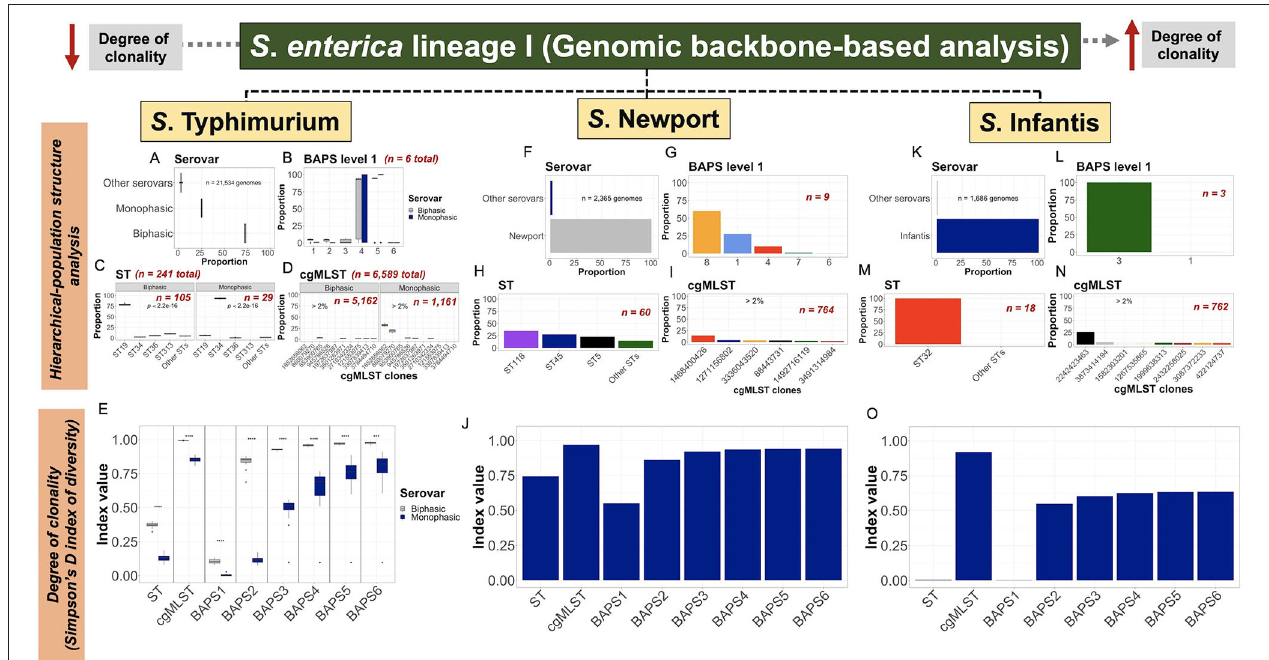
FIGURE 3 | Scalable core-genomic analysis of three zoonotic serovars of S . enterica lineage I linked population structure and genetic diversity with degree of clonality. Core-genomes (i.e., share-genomic content) alignments, generated independently for S . Typhimurium, S . Newport, or S . Infantis dataset, were hierarchically classified into serovar, BAPS1, ST, and cgMLST. Serovar was predicted using the cgMLST-based genotyping done by SISTR within ProkEvo. Frequency distributions were initially produced at each level of classification, and thereafter converted into proportions for population structure analysis; or used as input data (i.e., frequencies) for estimating the degree of clonality using the Simpson’s D index of diversity (1— D ). (A–D) Proportion of serovar ( n = 21,524 genomes), BAPS1 ( n = 21,524 genomes), ST ( n = 21,309 genomes), and cgMLST ( n = 19,226) classifications for S . Typhimurium (initial input of n = 21,534 genomes—“Worldwide”). (E) S . Typhimurium degree of clonality stratified by serotypic classification into: Biphasic vs. Monophasic; across ST ( n = 21,309 genomes), cgMLST ( n = 19,226 genomes), and BAPS1-6 levels ( n = 21,524 genomes for each BAPS layer from 1 to 6). A two-sided t- test was used to determine whether the two serovars significantly differed ( p < 0.05) from one another in their degree of clonality across genotypic levels. (F–I) Proportion of serovar ( n = 2,365 genomes), BAPS1 ( n = 2,365 genomes), ST ( n = 2,361 genomes), and cgMLST ( n = 2,289 genomes) classifications for S . Newport (initial input of n = 2,365 genomes—“USA only”). (J) Degree of clonality across the S . Newport population across ST ( n = 2,361 genomes), cgMLST ( n = 2,289 genomes), and BAPS1-6 levels of genotypic resolution ( n = 2,365 genomes for each BAPS layer from 1 to 6). (K–N) Proportion of serovar ( n = 1,686 genomes), BAPS1 ( n = 1,685 genomes), ST ( n = 1,683 genomes), and cgMLST ( n = 1,659 genomes) classifications for S . Infantis (initial input of n = 1,686 genomes—“USA only”). (O) Degree of clonality across the S . Infantis population using ST ( n = 1,683 genomes), cgMLST ( n = 1,659 genomes), and BAPS1-6 levels of genotypic resolution ( n = 1,685 genomes for each BAPS layer from 1 to 6). For the degree of clonality, the higher the value for the Simpson’s D index of diversity (index value), the less clonal or the more diverse the population is, at that specific level of genotypic resolution. Numbers ( n ) located inside and outside of each plot refers to the total number of sub-groups/haplotypes (BAPS1), ST lineages, and cgMLST variants found within the population, or sub-population (i.e., Biphasic vs. Monophasic), of each serovar. Missing values were dropped for all analyses to keep only genomes correctly classified by SISTR to that specific serovar. Of note, “Other serovars” represents serovars that were either not classified as any of the three ones used in this work, or were misclassified by SISTR within ProkEvo. The groups labeled as “Other STs” corresponded to low-frequency lineages present in each respective population. Across all serovars, only serovar-specific (predicted by SISTR) cgMLSTs for which the proportion was above 2%, were ultimately shown in the graph for aesthetic purposes. For S . Typhimurium plots (C) and (E) , asterisks refer to the degree of significance for differences calculated using a Chi-squared test and t- test, respectively (* p < 0.05, ** p ≤ 0.01, *** p ≤ 0.001, **** p ≤ 0.0001, and NS = not significant at p ≥ 0.05).